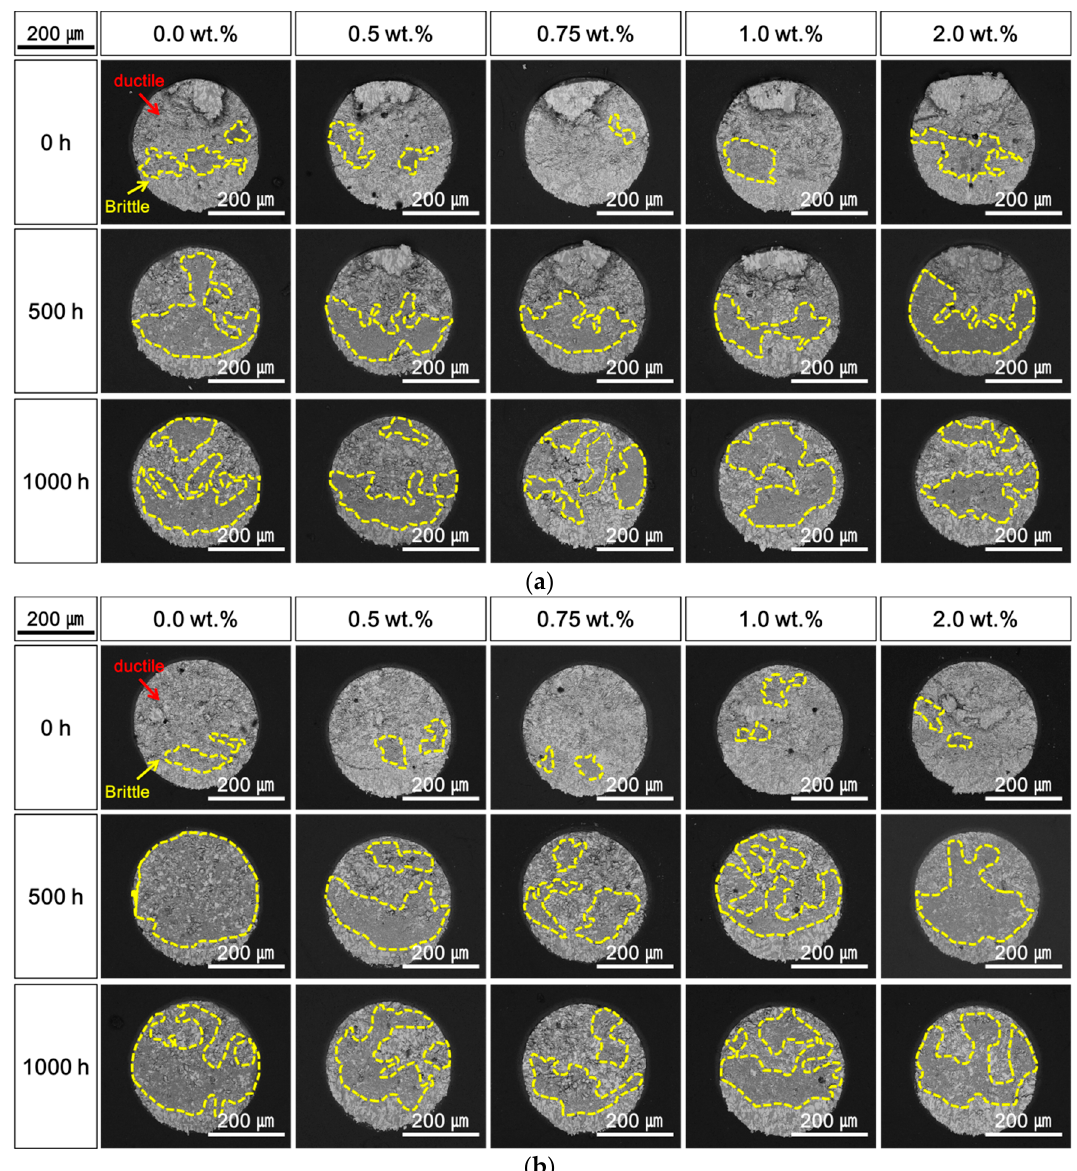
Figure 9. Top-view scanning electron microscopy (SEM) micrographs of fracture surfaces after a high-temperature storage (HTS) test at 100 °C: ( a ) 0.1 m/s and ( b ) 1.0 m/s.